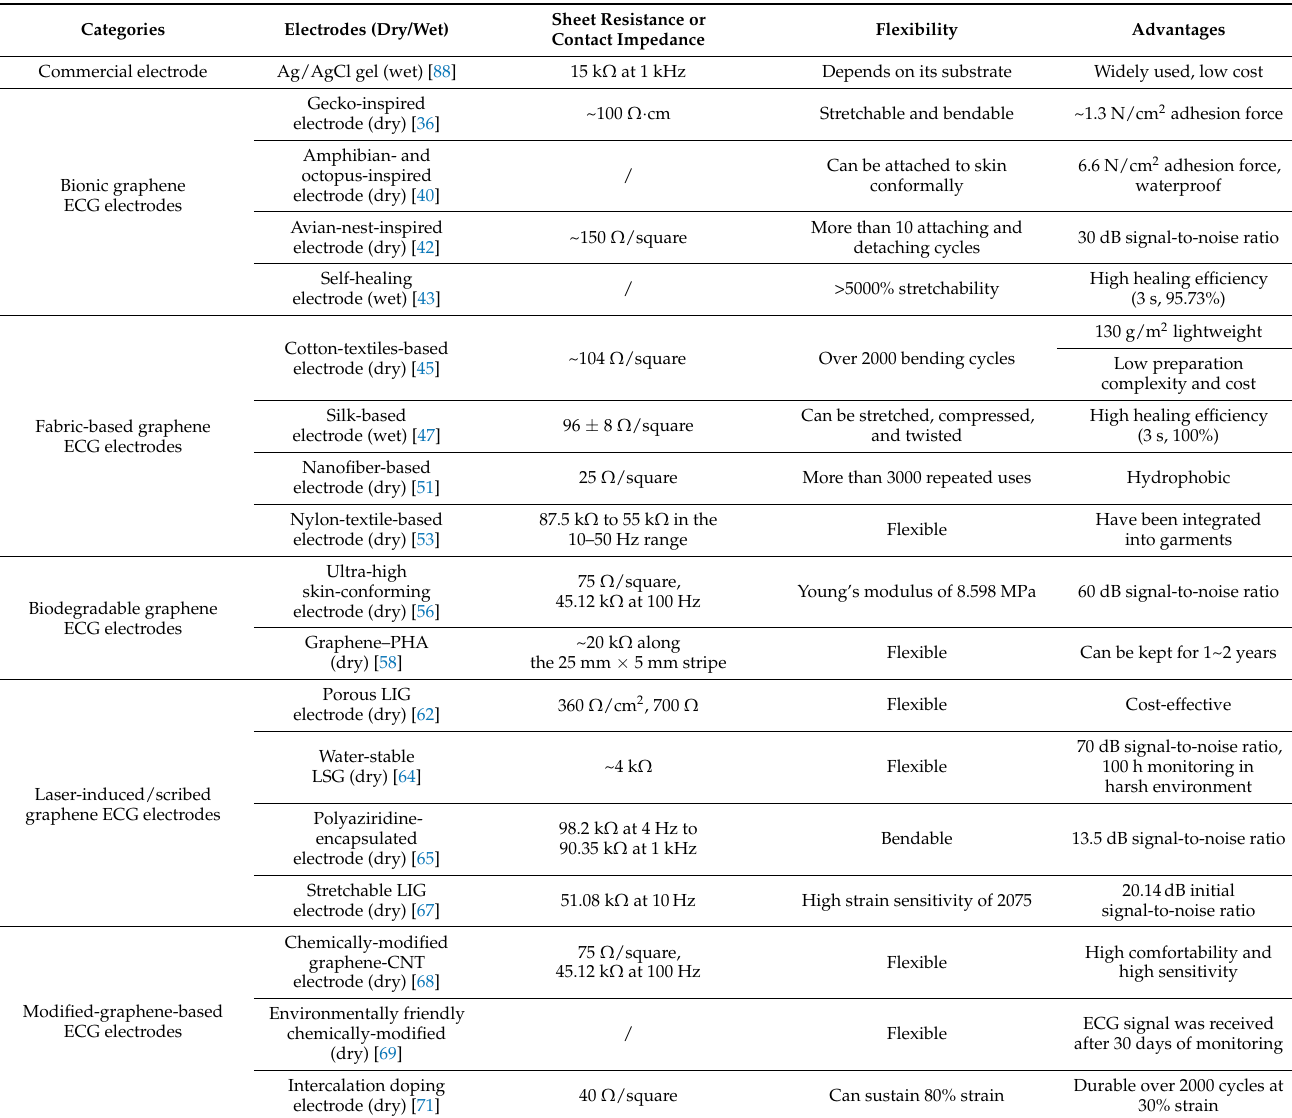
Table 1. Electrical and mechanical properties of the flexible, graphene-based ECG electrodes men- tioned above, with their decided